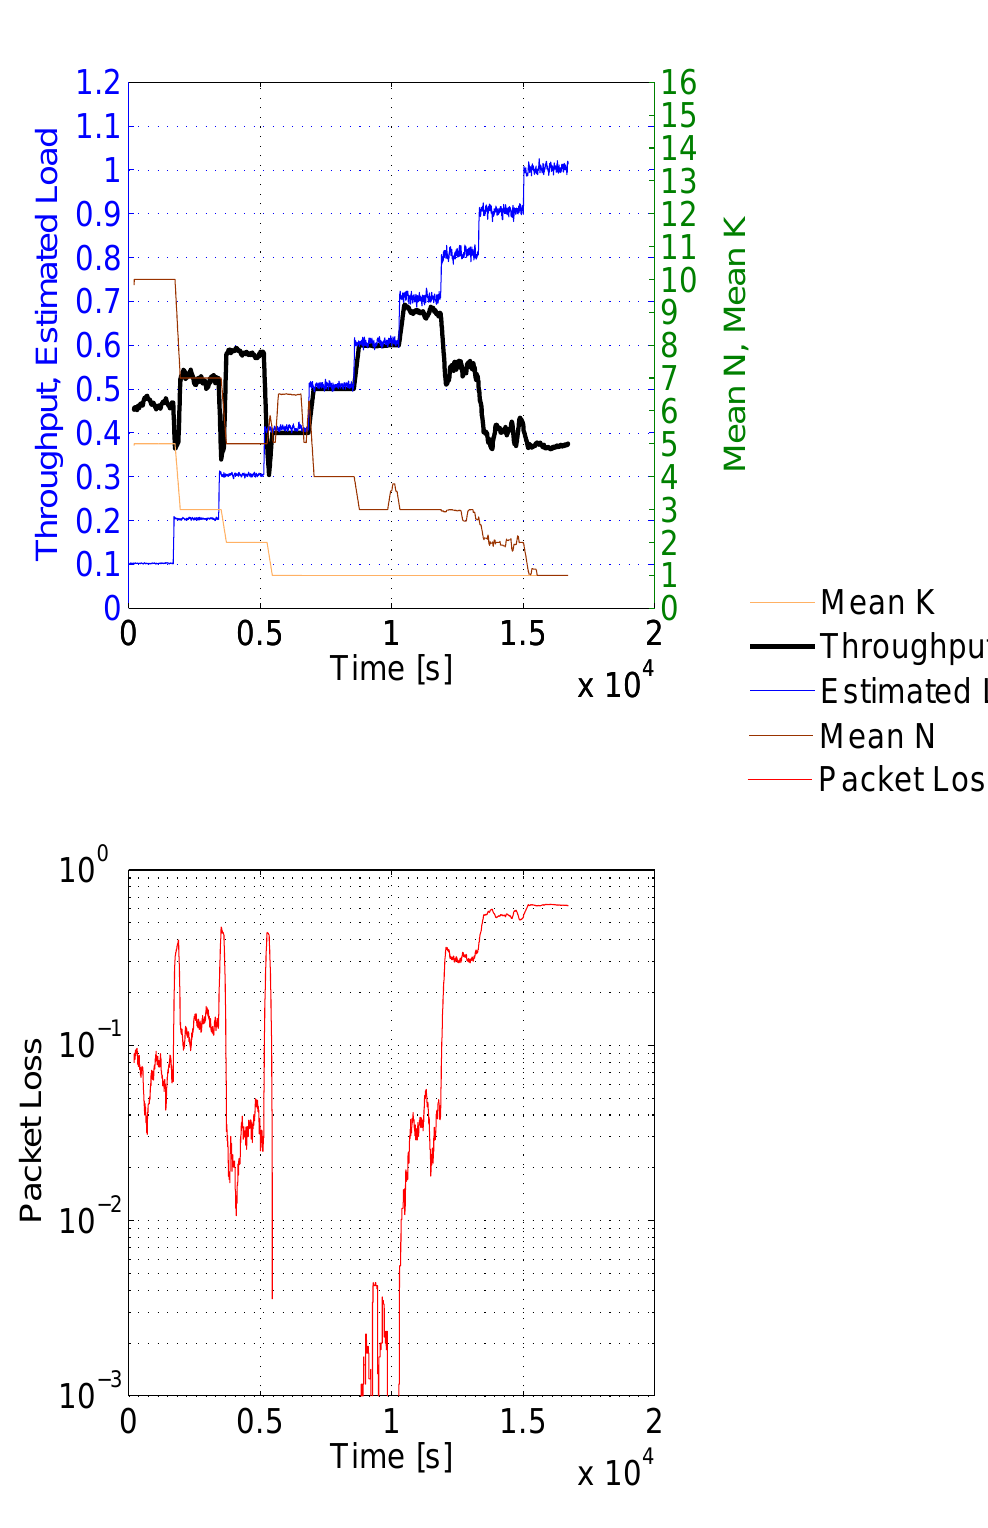
Figure 3. Throughput and Packet Loss for CE algorithm, linear code set C as in table ??